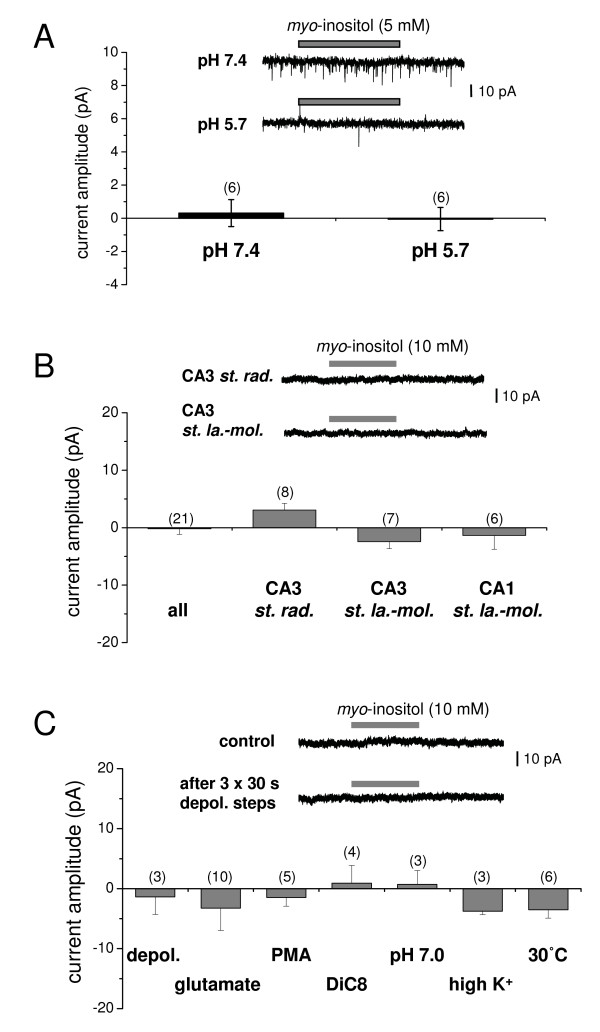
Absence of functional native plasma membrane HMIT with electrophysiological analysis. A Summary data showing that myo-inositol (5 mM) did not evoke any currents at either pH 5.7 or 7.4 in rat cultured cortical neurones. Inset, representative traces of typical recordings. The downward deflections are spontaneously-occurring synaptic currents because TTX was not included as the effects on HMIT-mediated responses were unknown (n numbers in parentheses). B Summary data showing that micro-pressure application of myo-inositol (10 mM) did not induce any current responses in interneurones in different regions of rat hippocampal slices. Inset, representative traces of typical recordings from a CA3 stratum radiatum and a CA3 stratum lacunosum-moleculare interneurone. C Summary data showing that inositol-evoked currents were not observed following a variety of stimulation protocols. (Depol.: three 30 s steps of depolarising current injection in current-clamp mode to induce action potential firing, glutamate, PMA, DiC8, pH 7.0: pressure application of myo-inositol dissolved in pH 7.0 extracellular solution; high K+, 30°C: pre-incubation of slices at 30°C for >2 h before recording). Inset, representative traces of a typical recording of a CA3 stratum lacunosum-moleculare interneurone before (control) and after three depolarising steps. The stimulation paradigm did not promote responses to myo-inositol application.